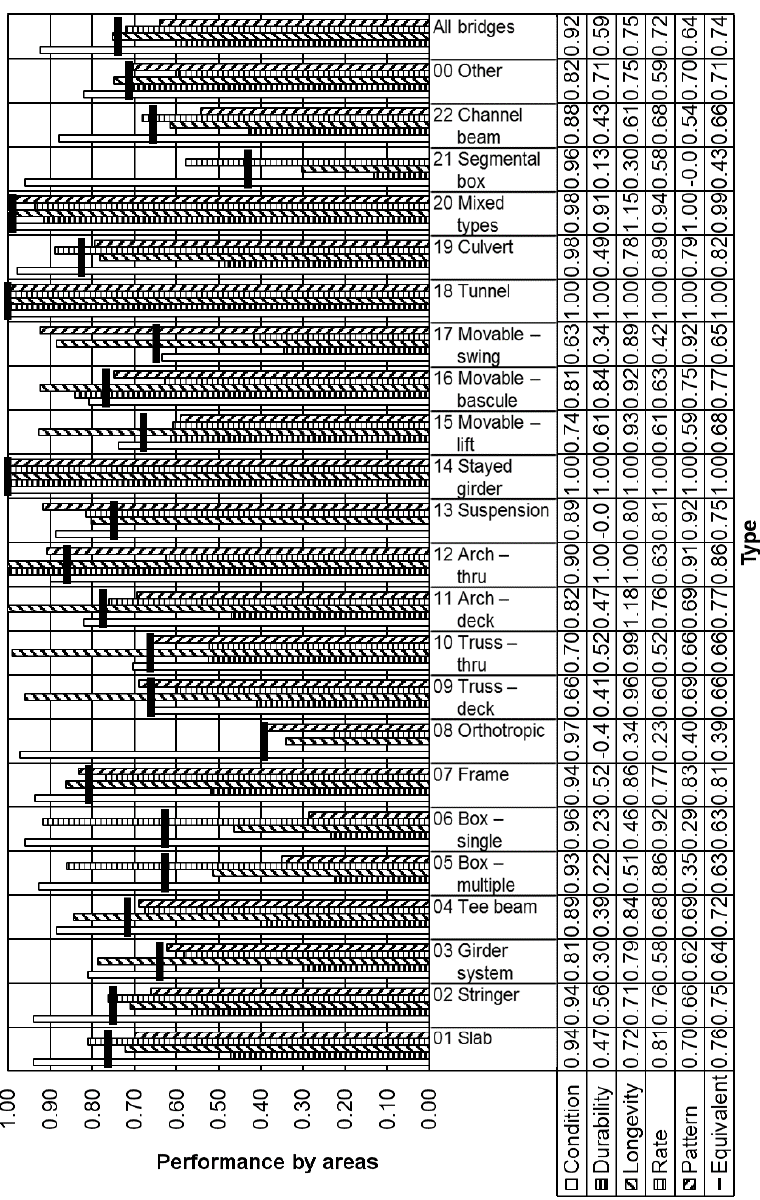
Figure 14. Comparison of structural performances of bridge types by areas.